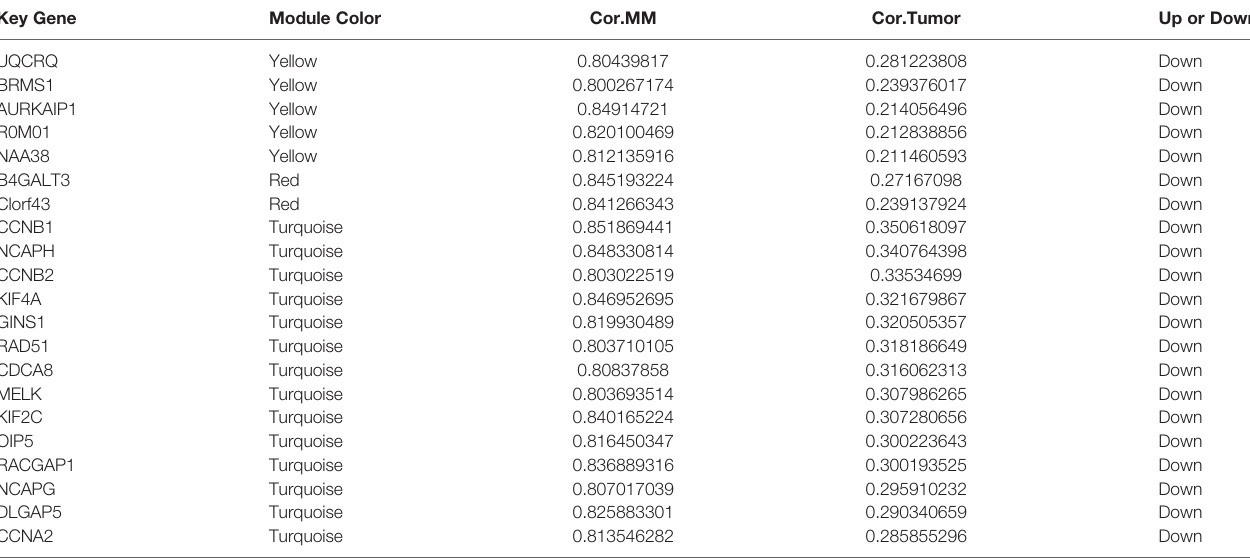
TABLE 1 | The information of 21 UCEC key genes. Key